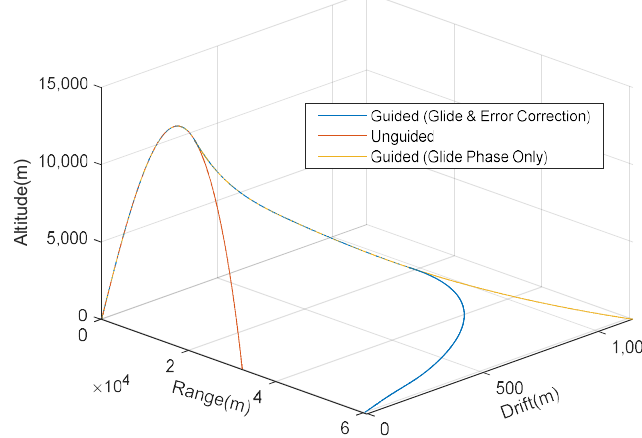
Figure 19. Altitude vs. Range.